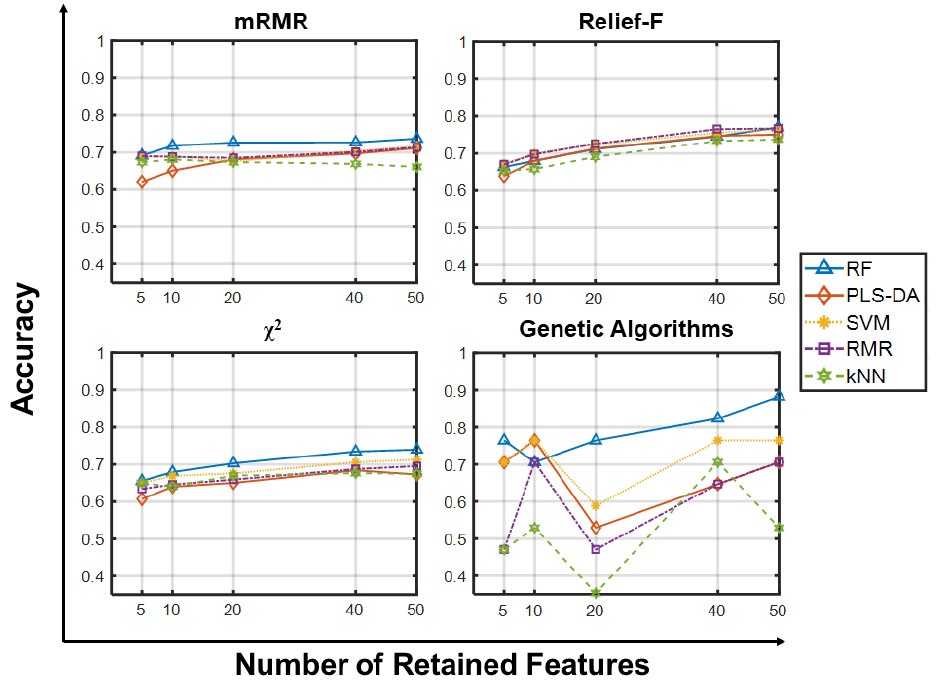
Figure 5. Predictive accuracy using few retained features on CLL_SUB_111. Predictive accuracies of the classifiers (RF, PLS-DA, SVM, RLR, kNN) vs. Number of Retained Features (5, 10, 20, 40, 50) on the CLL_SUB_111 dataset using the four feature selection methods. Each point in panels for mRMR, Relief-F and Chi-squared is the average predictive accuracy computed over 100 resamplings, while those for GA corresponds to a single value.